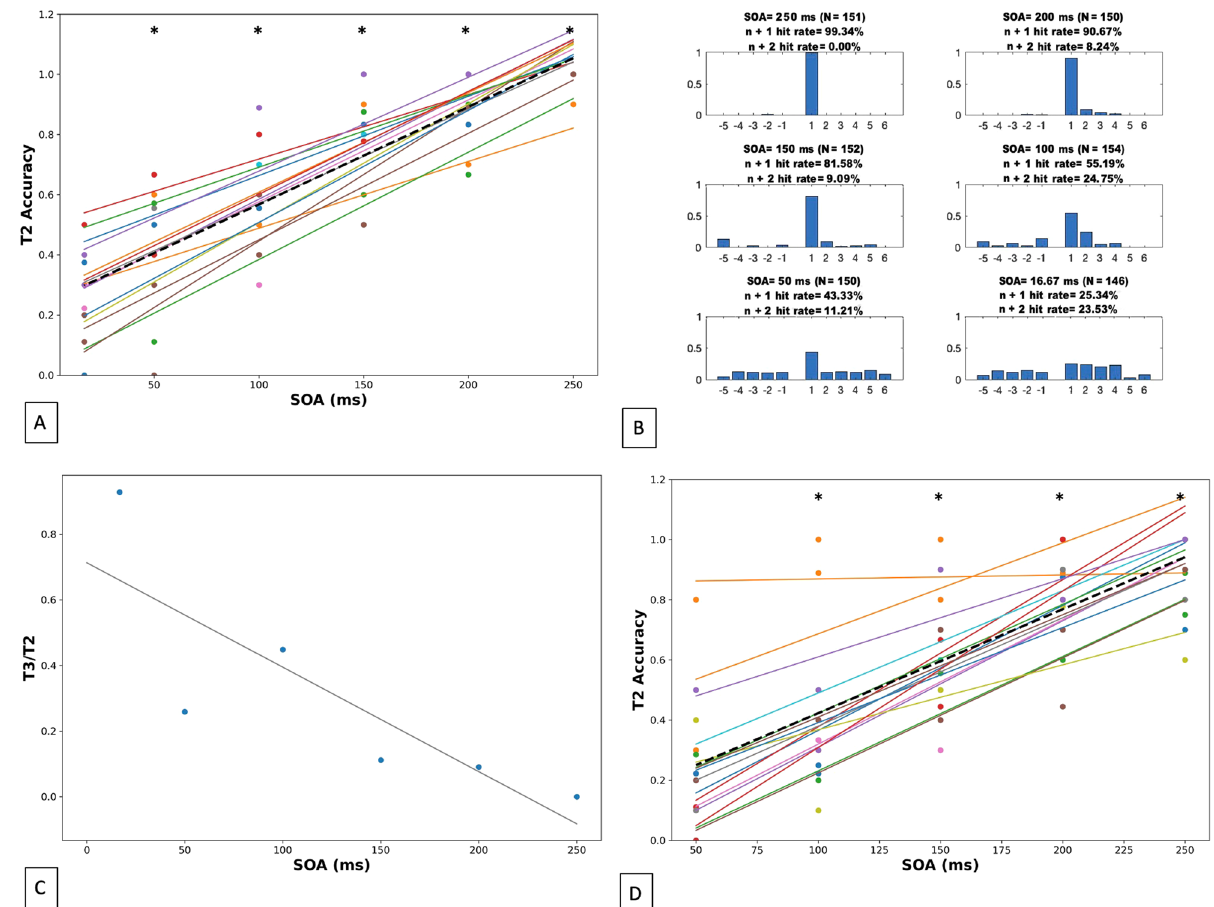
Figure 2. Temporal threshold for lag 1 sparing lies between 50 and 100 ms. Asterisks (*) indicate T2 accuracy was significantly greater than chance (0.1667). ( A ) Variation of presentation rate and image duration (uncontrolled condition). Average T2 (lag 1) accuracy for each SOA [16.67–250 ms] across 16 subjects shows increasing accuracy as the SOA increases. Linear fit for each individual subject is shown by the solid-colored lines (range of slops: [0.0021, 0.0044]). Group effect shown by the dashed black line (slope = 0.0032). Only T2 accuracy at SOA = 16.67 ms were not significantly different than chance ( p = 0.052). ( B ) Average T2 accuracy (y-axis) by distance from the target in the RSVP stream (x-axis) for each SOA. Number of trials represented by the data in each subplot is shown in parenthesis. ( C ) Ratio of n + 2/n + 1 hit rates across SOAs demonstrates an increase in the proportion of T3 errors relative to T2 as presentation rates increase. Grey line represents linear regression fit to plotted data points. ( D ) Variation of presentation rate while controlling for image duration. Average T2 (lag 1) accuracy for each SOA [50-250 ms] across 16 subjects on trials shows increasing accuracy as the SOA increases. Linear fit for each individual subject is shown by the solid-colored lines (range of slopes: [0.0026, 0.0052]). Group effect shown by the dashed black line (slope = 0.0035). T2 accuracy at 50 ms SOA was not significantly different than chance ( p =